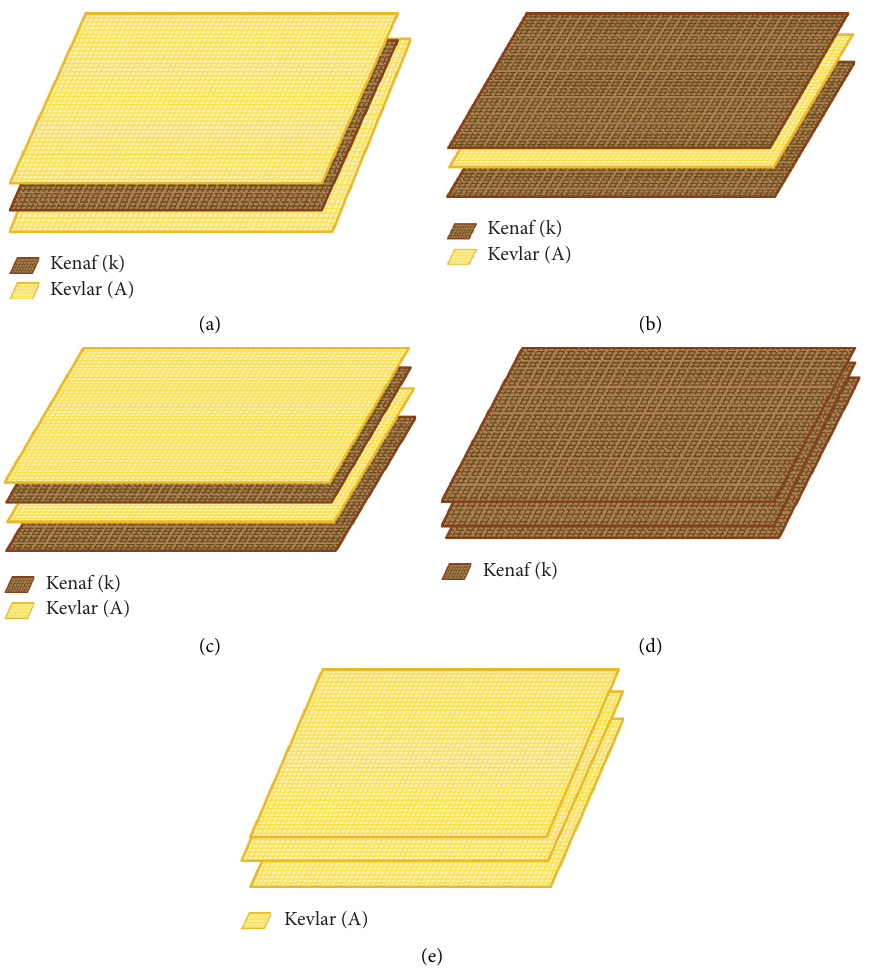
Figure 9: Stacking sequence for composites configuration: (a) A/ k /A; (b) k/A/ k ; (c) A/ k /A/ k ; (d) k/ E; and (e) Kevlar/epoxy